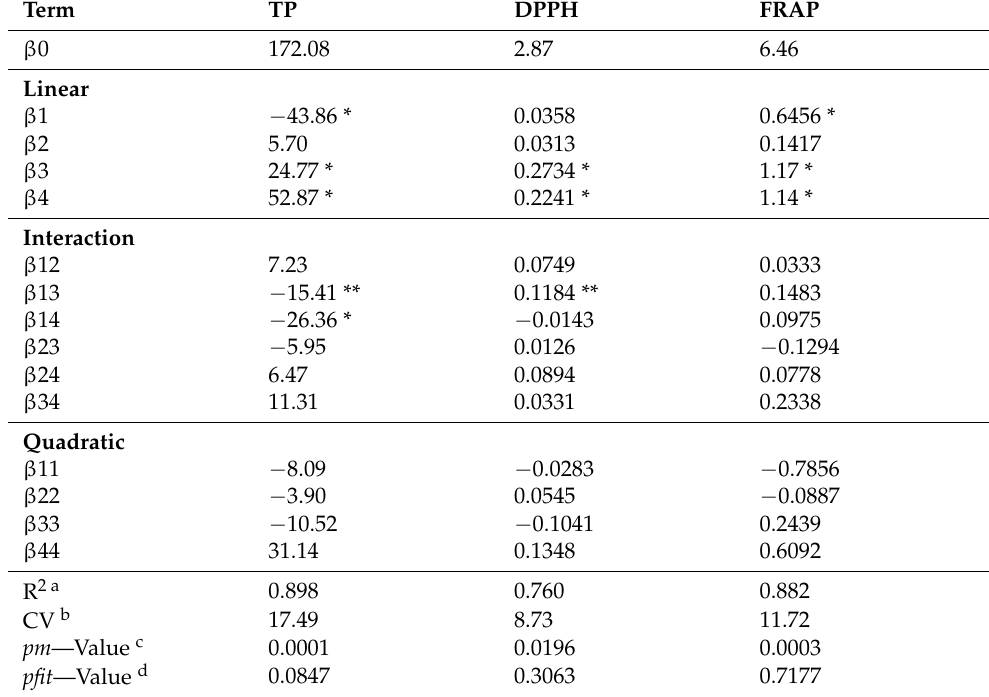
Table 2. The results of ANOVA